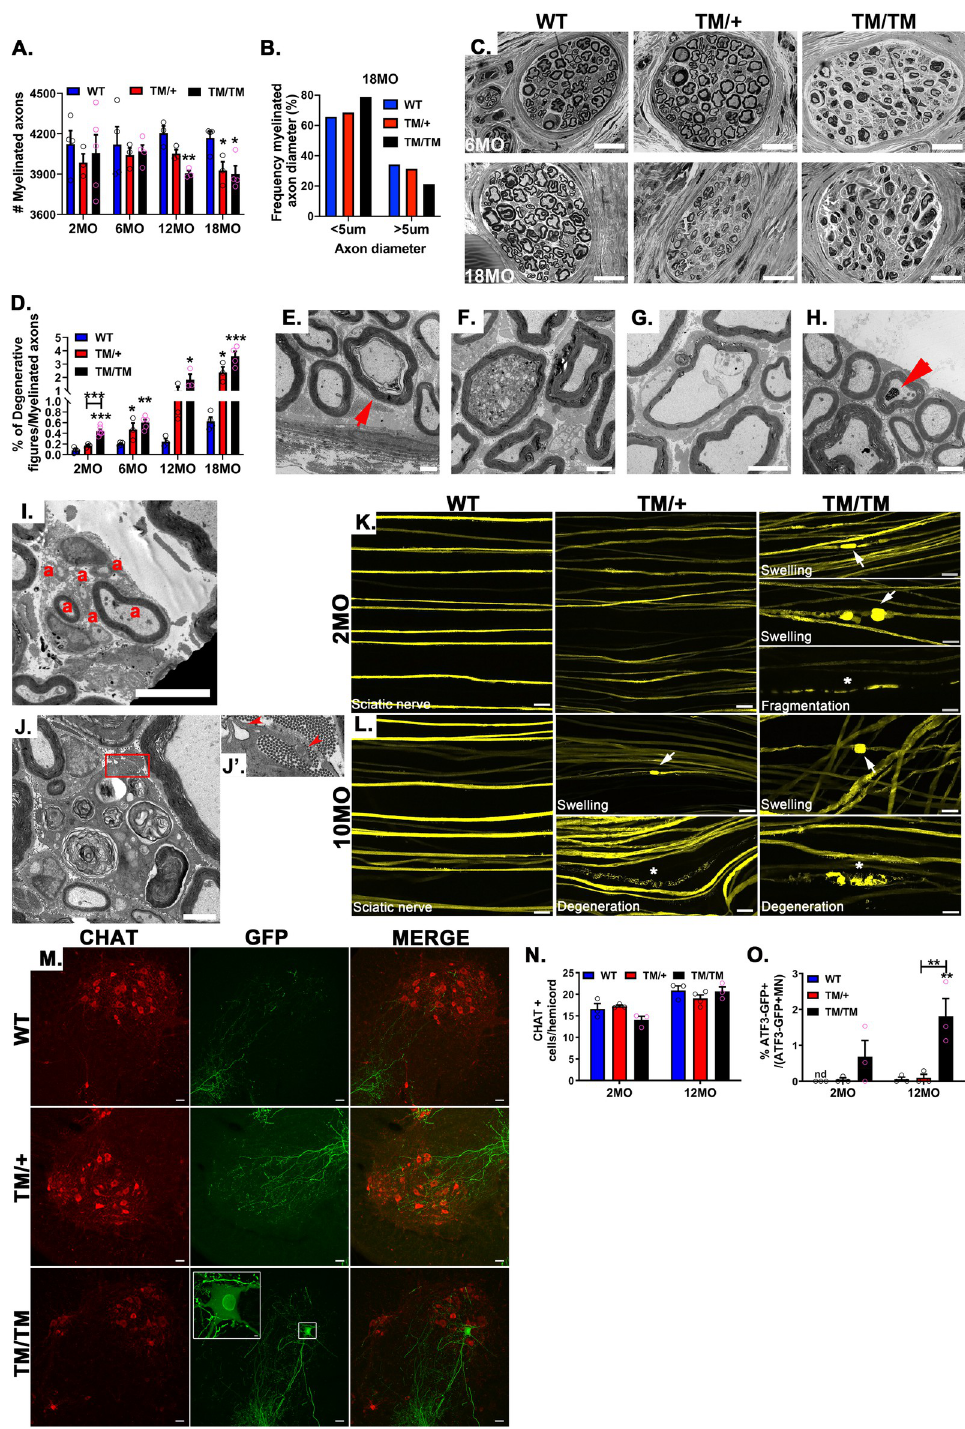
Fig 3. P0T124M mutation causes axonal degeneration. ( A ) Quantification of myelinated axons in whole sciatic nerves at 2, 6, 12, and 18 months of age. Starting at 12 months of age, the number of myelinated axons is significantly reduced in Mpz T124M mice. One-way ANOVA [2 month old: F (2, 9) = 0.2896, p = 0.7553; 6 month old: F (2, 8) = 0.1831, p = 0.8361; 12 month old: F (2, 6) = 15.97, p = 0.0040; 18 month old: F (2, 8) = 7.077, p = 0.0170]. ( B ) Frequency distribution of myelinated axons as a function of axonal diameter shows that big axons ( > 5 μ m in diameter) are slightly more impacted than small axons ( < 5 μ m), especially in 18-month-old Mpz T124M/T124M (TM/TM) mice. ( C ) Semithin cross sections of